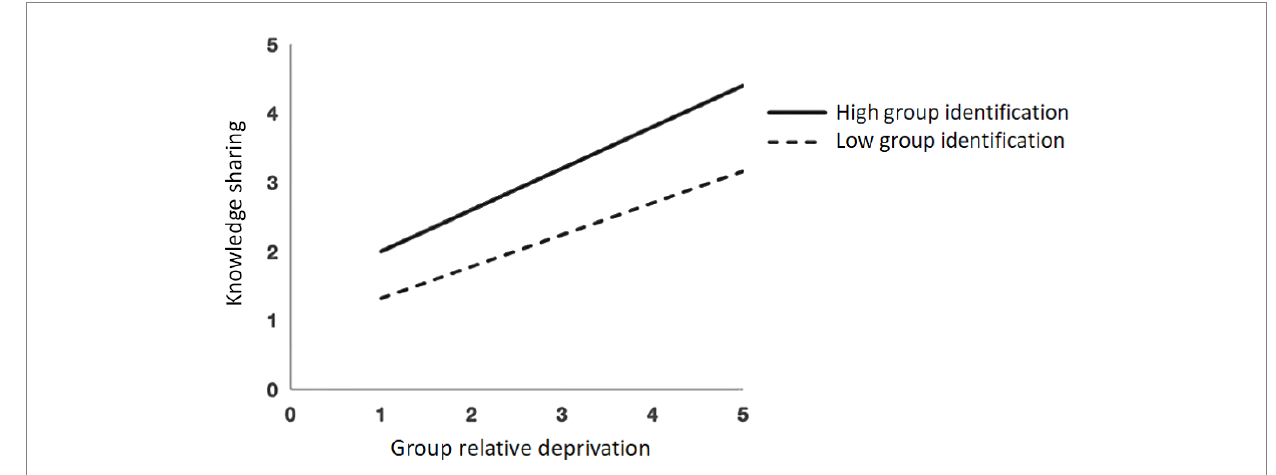
FIGURE 1 The moderating effect of group